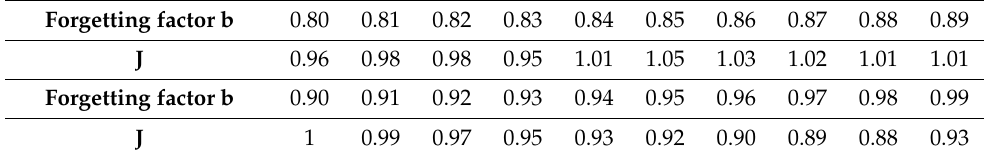
Table 5. Forgetting factor search for optimal evaluation index.